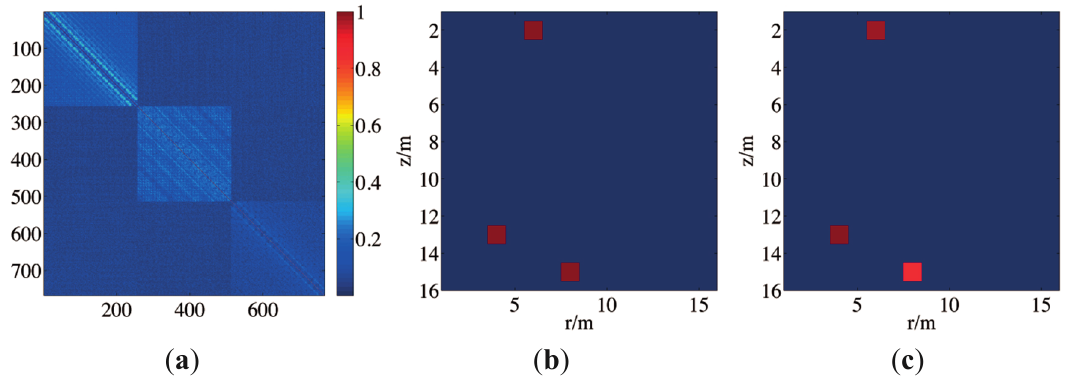
Figure 7. ( a ) A Gram matrix of  in a multi-frequency case; ( b ) The targets of interest; ( c ) The recovery result.